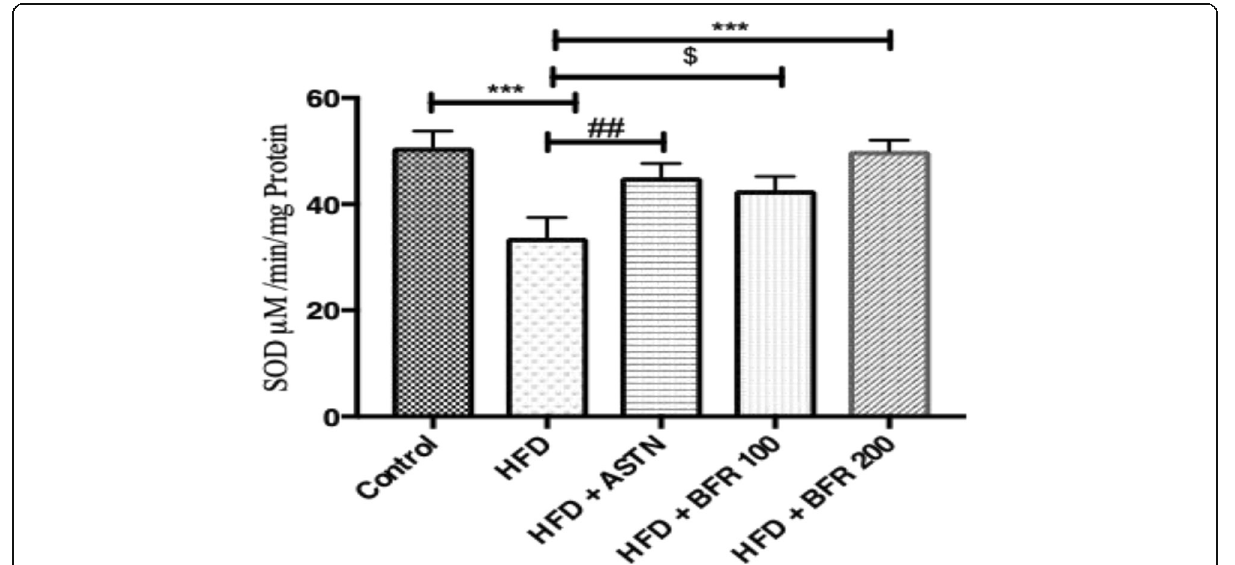
Fig. 5 Effect of BFR and ATSN in heart SOD level of high-fat diet-fed rats. Data were expressed as mean ± SD. Comparison made between HFD vs control and HFD + ATSN vs HFD group, HFD + BFR vs HFD. Statistical significance at $ p < 0.05, ## p < 0.001, and *** p < 0.001